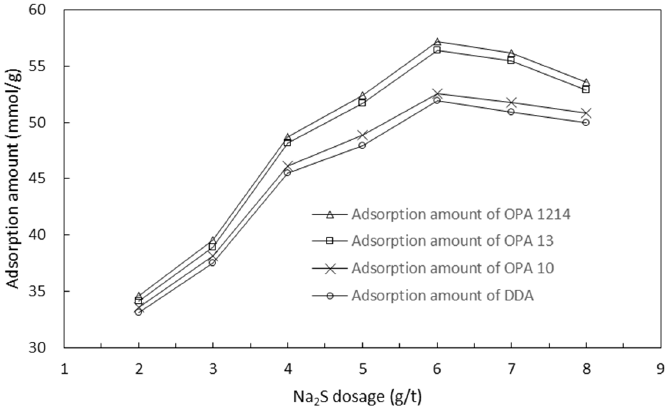
Figure 8. Adsorption amount of each collector on smithsonite particles at different Na 2 S concentra ‐ tions (Na 2 SiO 3 of 500 g/t).